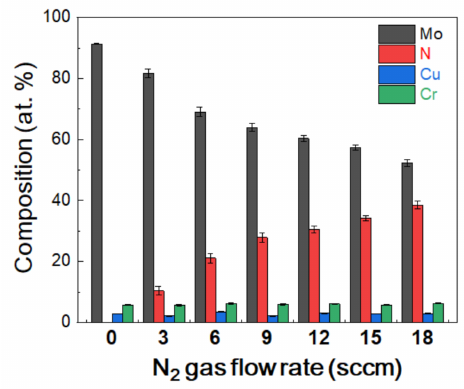
Figure 3. Relative elemental composition of the Mo–Cu–Cr–N coatings deposited at various N 2 gas flow rates.